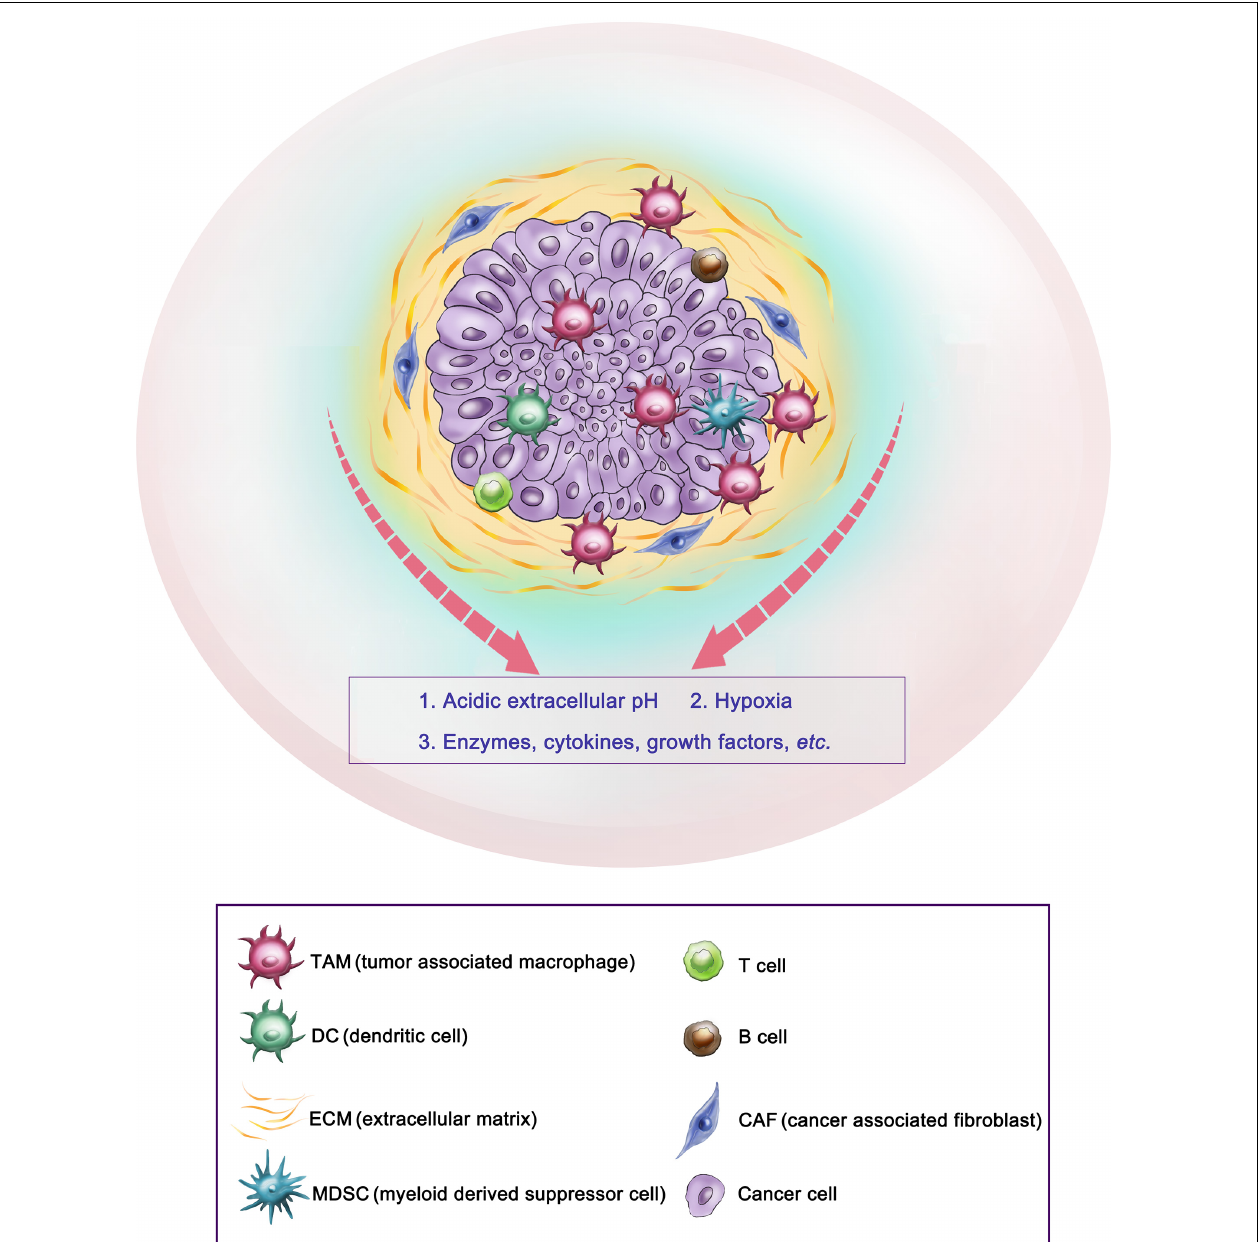
FIGURE 2 | Representative tumor microenvironment of a solid tumor. This scheme shows the representative tumor microenvironment of a solid tumor (pancreatic ductal adenocarcinoma). The tumor microenvironment in solid tumors commonly consists of tumor-associated macrophages (TAM), cancer-associated fibroblasts (CAF), extracellular matrix (ECM), etc. , and abnormal physiological environments such as acidic extracellular pH and hypoxia, as well as overexpressed enzymes, cytokines,